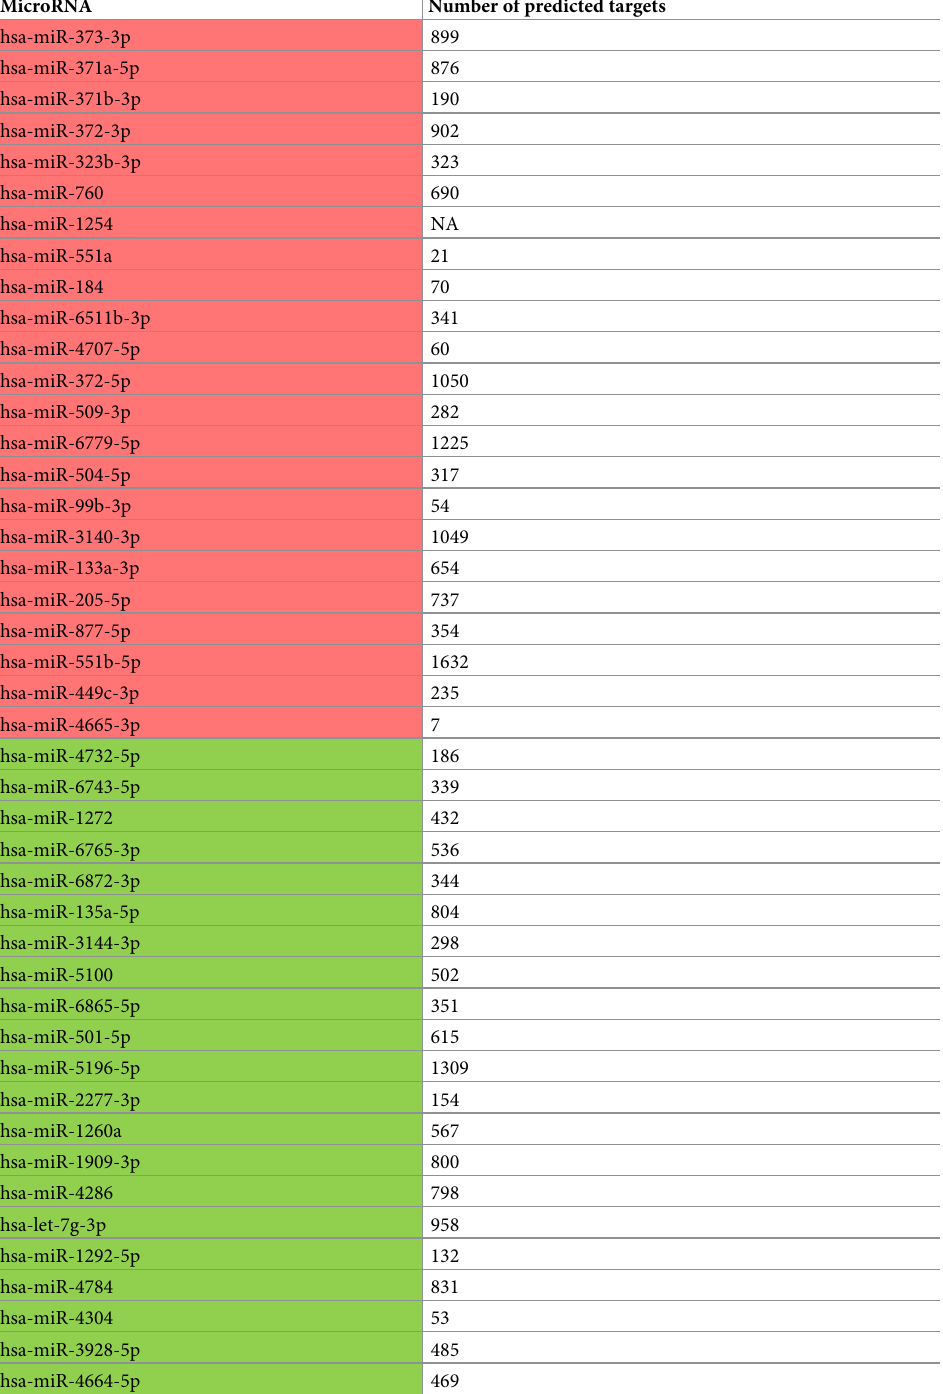
Table 5. Number of predicted targets of miRNAs in the placental miRNAome. Predicted targets for each miRNA were determined by analyzing an online database for miRNA target prediction and functional annotations (miRDB) [44,45].The target prediction score was set between 50 and 100. Because of the high number of predicted targets for each miRNA, only the number of targets are shown. Results for targets of up- and downregulated miRNAs are shown in red and green, respectively. miRNAs are listed in the same order as in Table